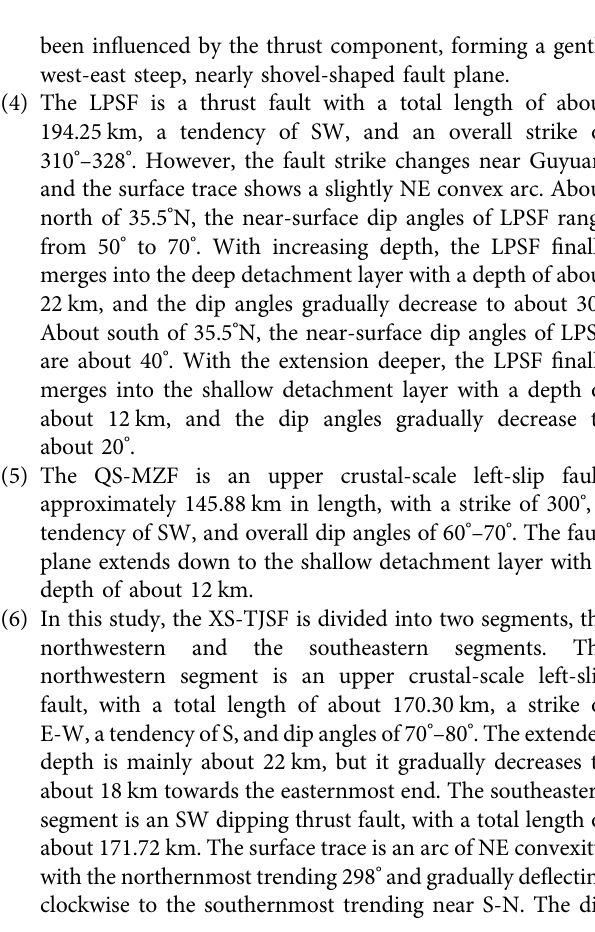
Frontiers in Earth Science |